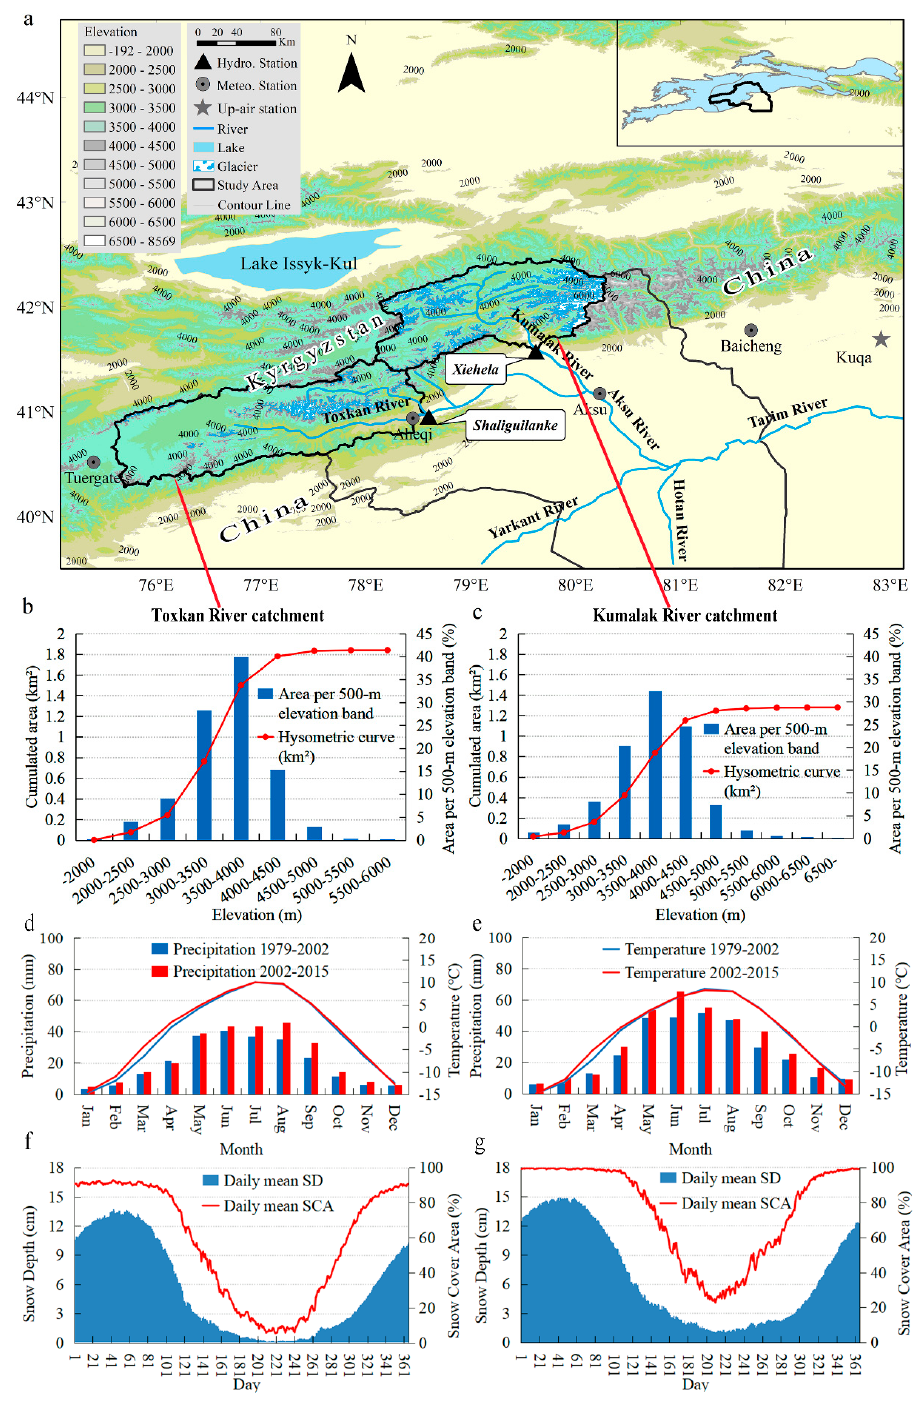
Figure 1. ( a ) Location of research area; ( b , c ) hypsometric curves of Toxkan and Kumalak catchment areas and proportion of layer areas under each 500 m altitude; ( d , e ) monthly distribution of temperature and precipitation in Toxkan and Kumalak River catchments during 1979–2002 and 2002–2015; ( f , g ) monthly distribution of snow depth (SD) and snow cover area (SCA) in the Toxkan and Kumalak River catchments during 1979–2002 and 2002–2015.